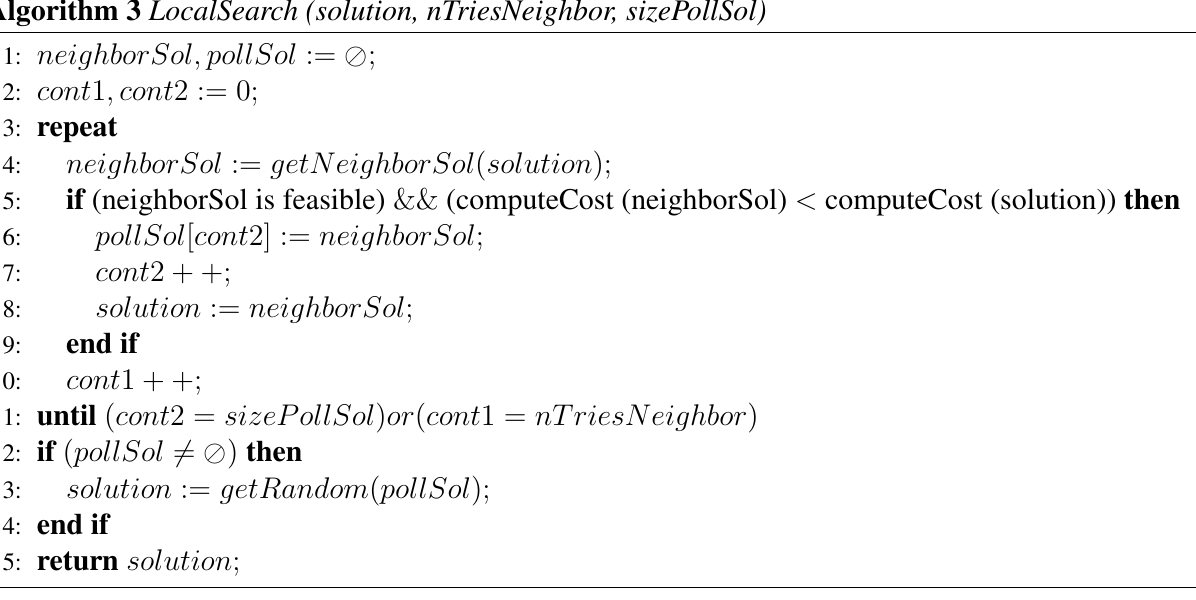
Algorithm 3 LocalSearch (solution, nTriesNeighbor,